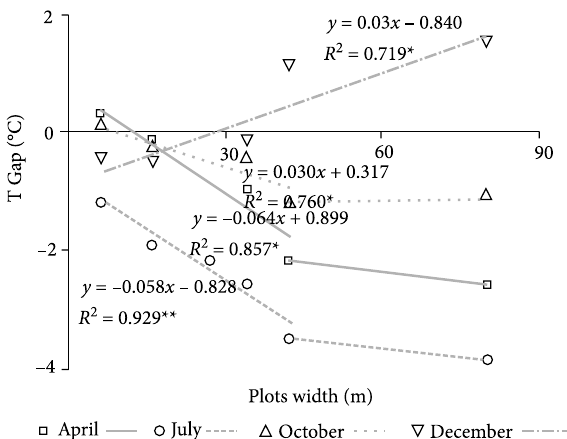
beltsFig. Fig. 8. Linear correlation analysis of average RH in green Fig. 9. Scatter diagram of the correlation trend of air T and